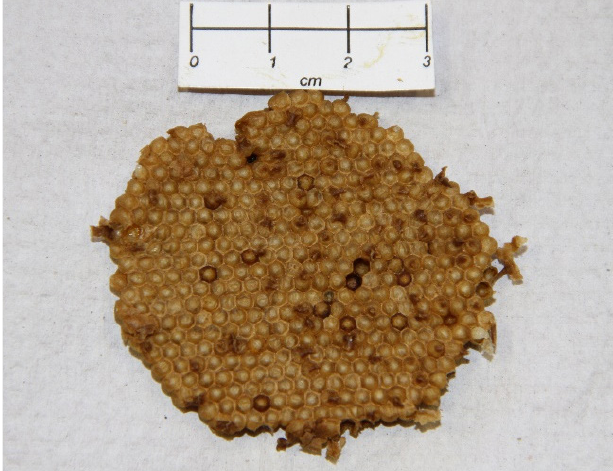
Fig 2. Brood comb of the Plebeia droryana used to estimate immatures. Scale bar = 3 Table 1. Number of the nest structures, brood combs, adult individuals estimative and immature estimative and the mean ±SD, respectively.